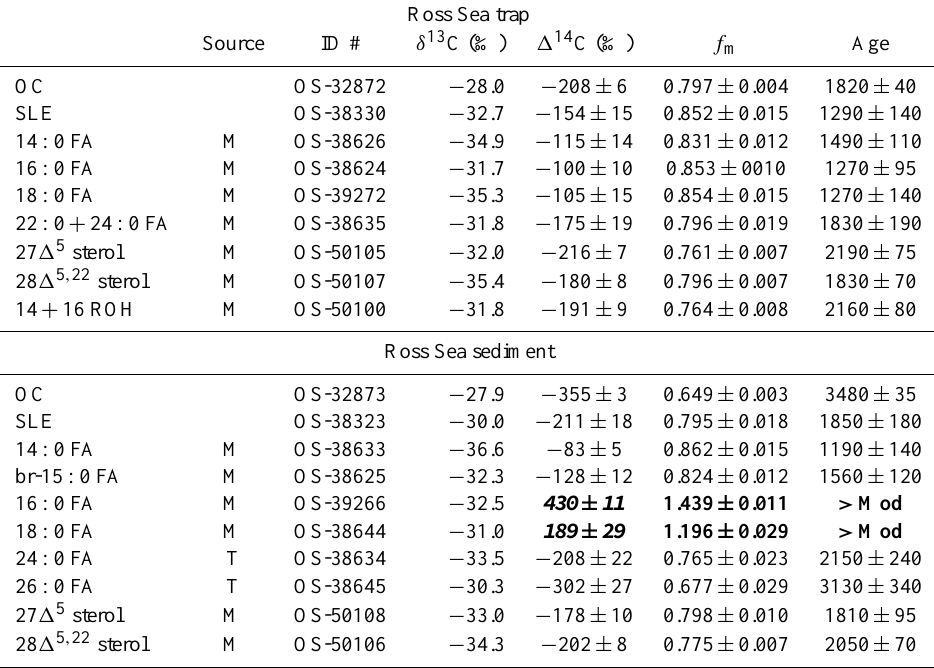
Table 3. Stable carbon and radiocarbon isotope data for Ross Sea POM and SOM. Bold italicized values were not used in calculations (see